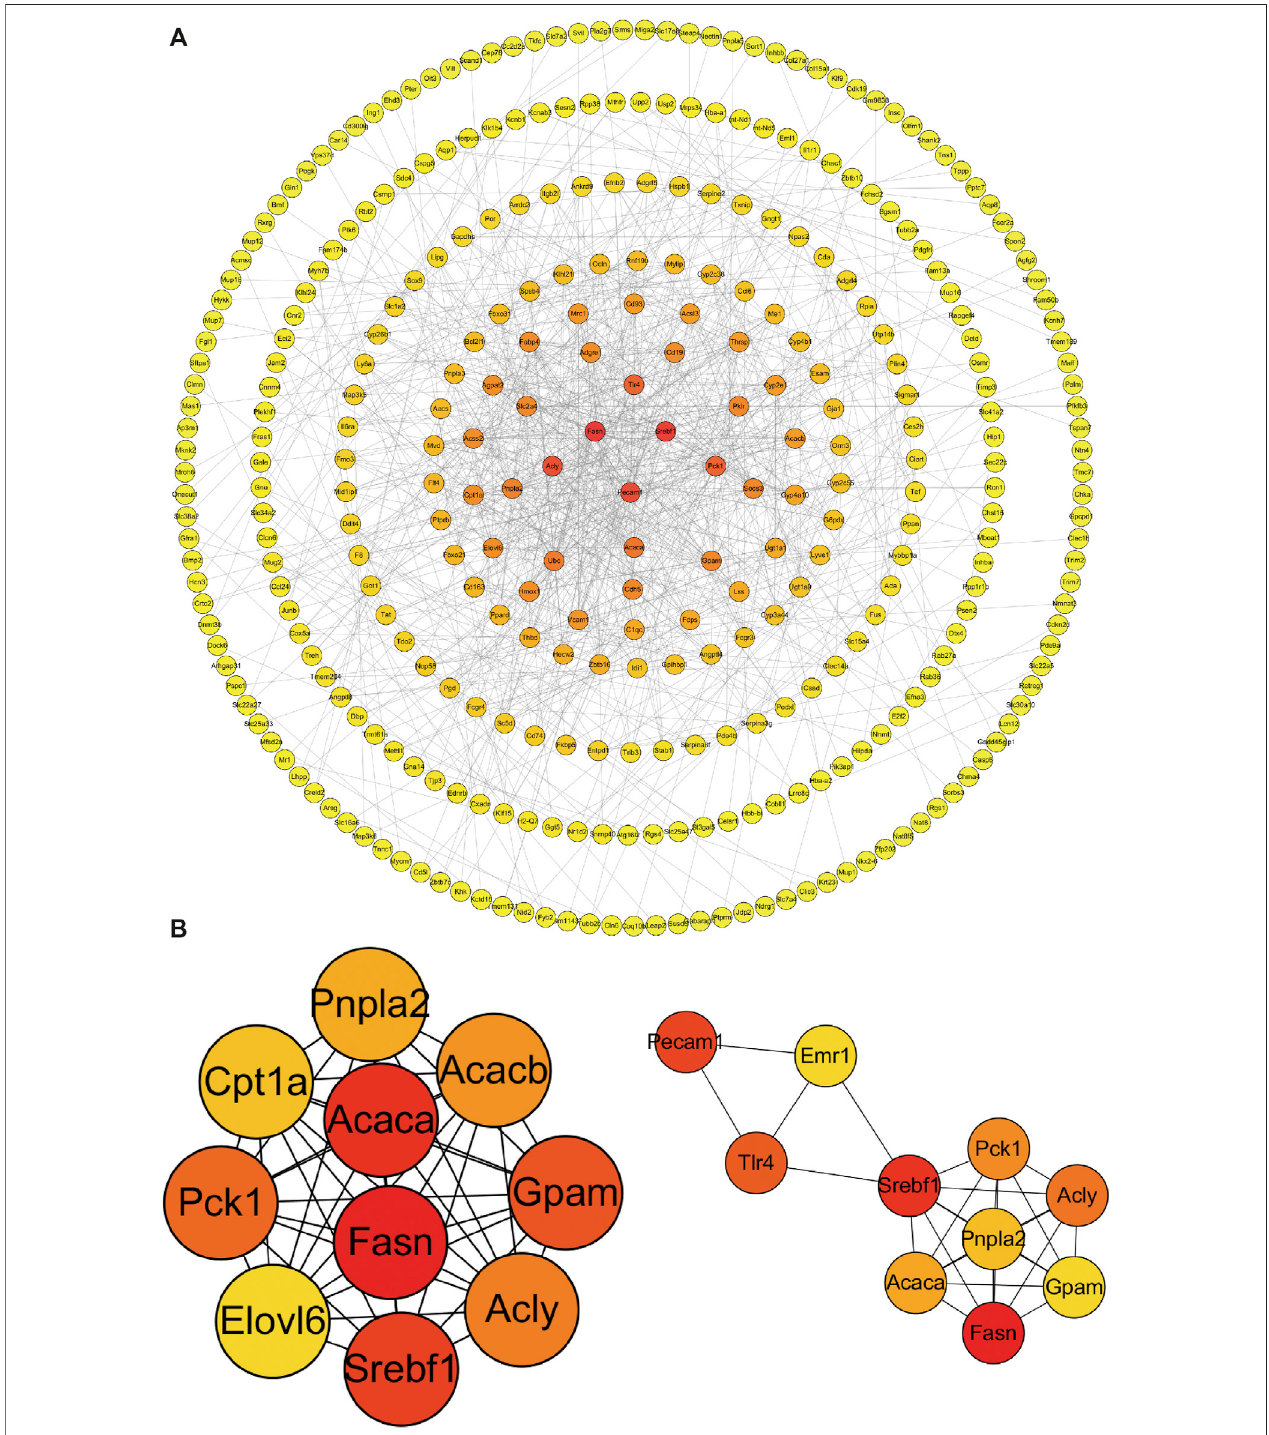
FIGURE 5 | PPI network (A) and hub genes (B) of all DEGs identi fi ed among the three groups. Red balls show the hub genes. PPI, protein – protein interaction.